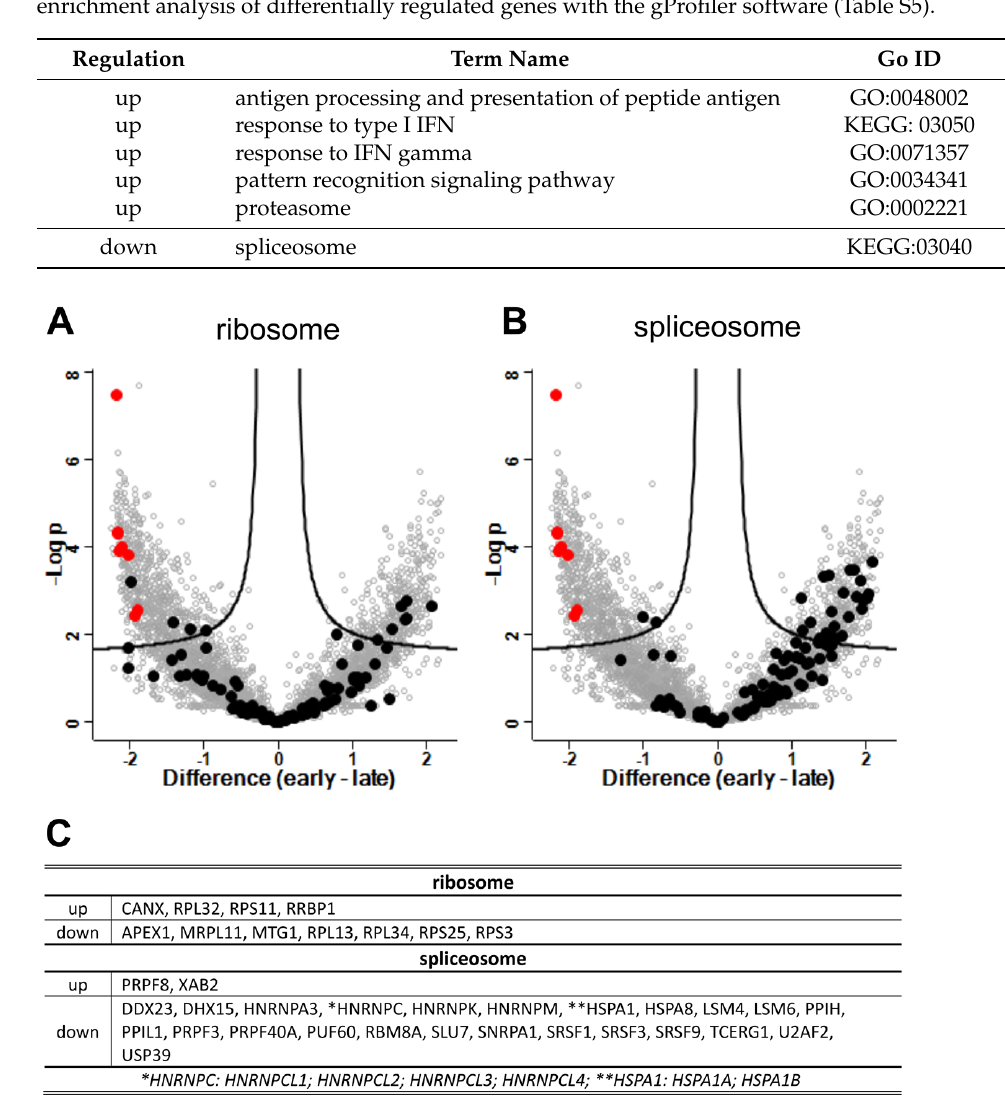
Figure 9. Differentially expressed genes (DEG) in late and early phases of infection: virus proteins, ribosome (KEGG:03010), and spliceosome (KEGG:03040). Volcano plots highlight genes annotated with GO terms ( A ) ribosome (KEGG:03010) and ( B ) spliceosome (KEGG:03040). NiV proteins are highlighted in red as reference for upregulated genes. Black dots represent cellular proteins of the respective pathways. ( C ) Regulated DEG corresponding to GO terms. *: No differentiation of the indicated HNRPNPCVs was possible. **: no differentiation of HSPA1A and HSPA1B was possible.